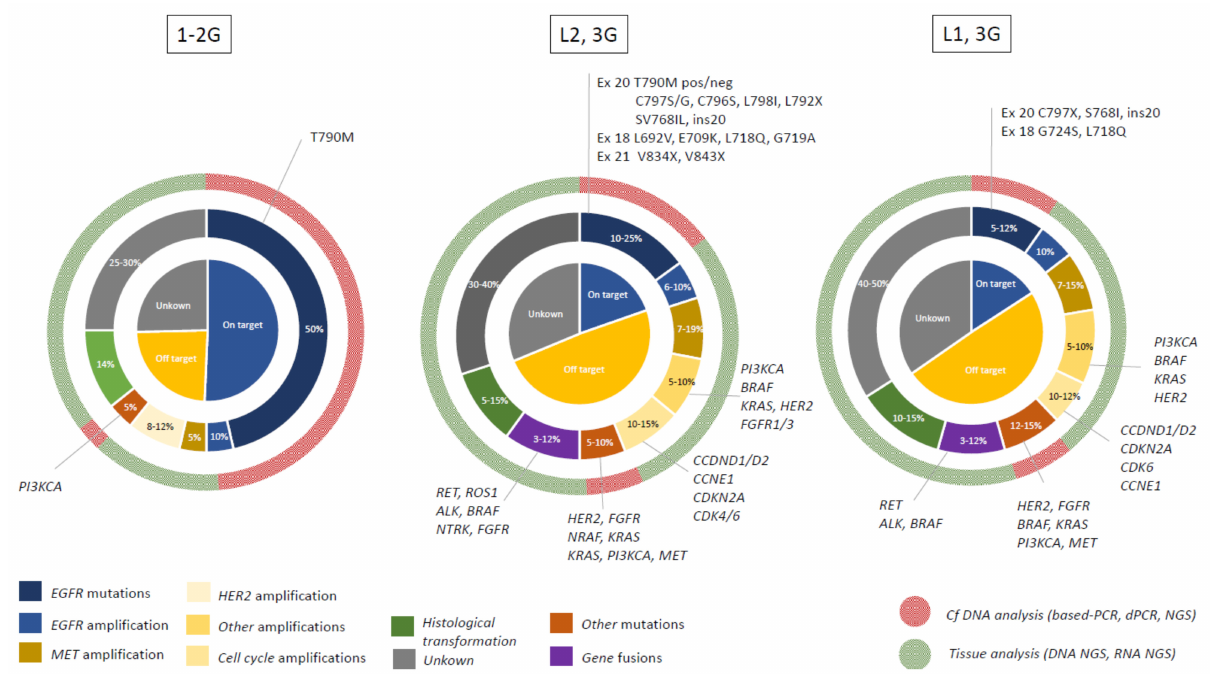
Figure 2. Mechanisms of resistance to EGFR-TKIs, depending on the generation of TKIs and on the line of therapy; 1–2G :first–second-generation EGFR-TKI; 3G:third-generation EGFR-TKI; L1:first line of treatment; L2:second line of